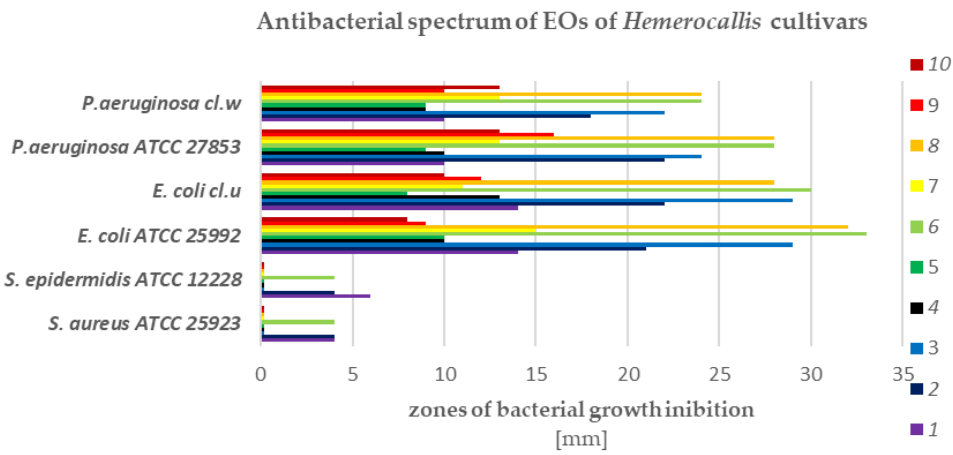
Figure 4: Range of antibacterial spectrum of EOs of Hemerocallis cultivars tested against Gram-negative and Gram-positive bacterial strains.